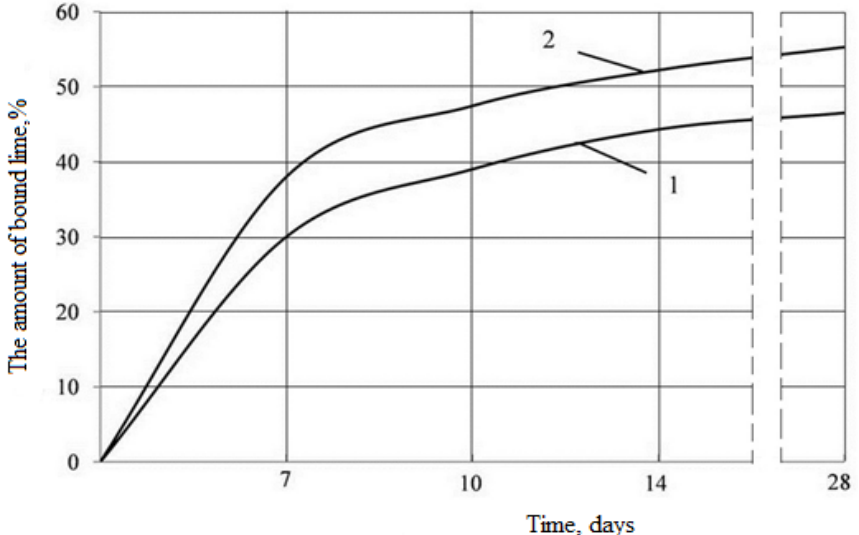
Figure 6. Change in the amount of bound lime during the hardening process 1 — control; 2 — with the use of an additive based on synthetic aluminosilicates.